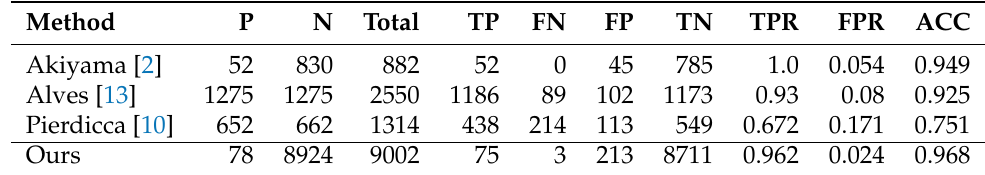
Table 5. Qualitative comparison of our anomaly detection algorithm with state-of-the-art methods. Method